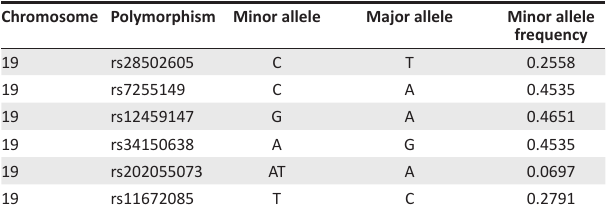
Table 1-A1 (Continues...): Minor allele frequencies for 1846 polymorphisms in 43 black South Africans. Chromosome Polymorphism Minor allele Major allele Minor allele